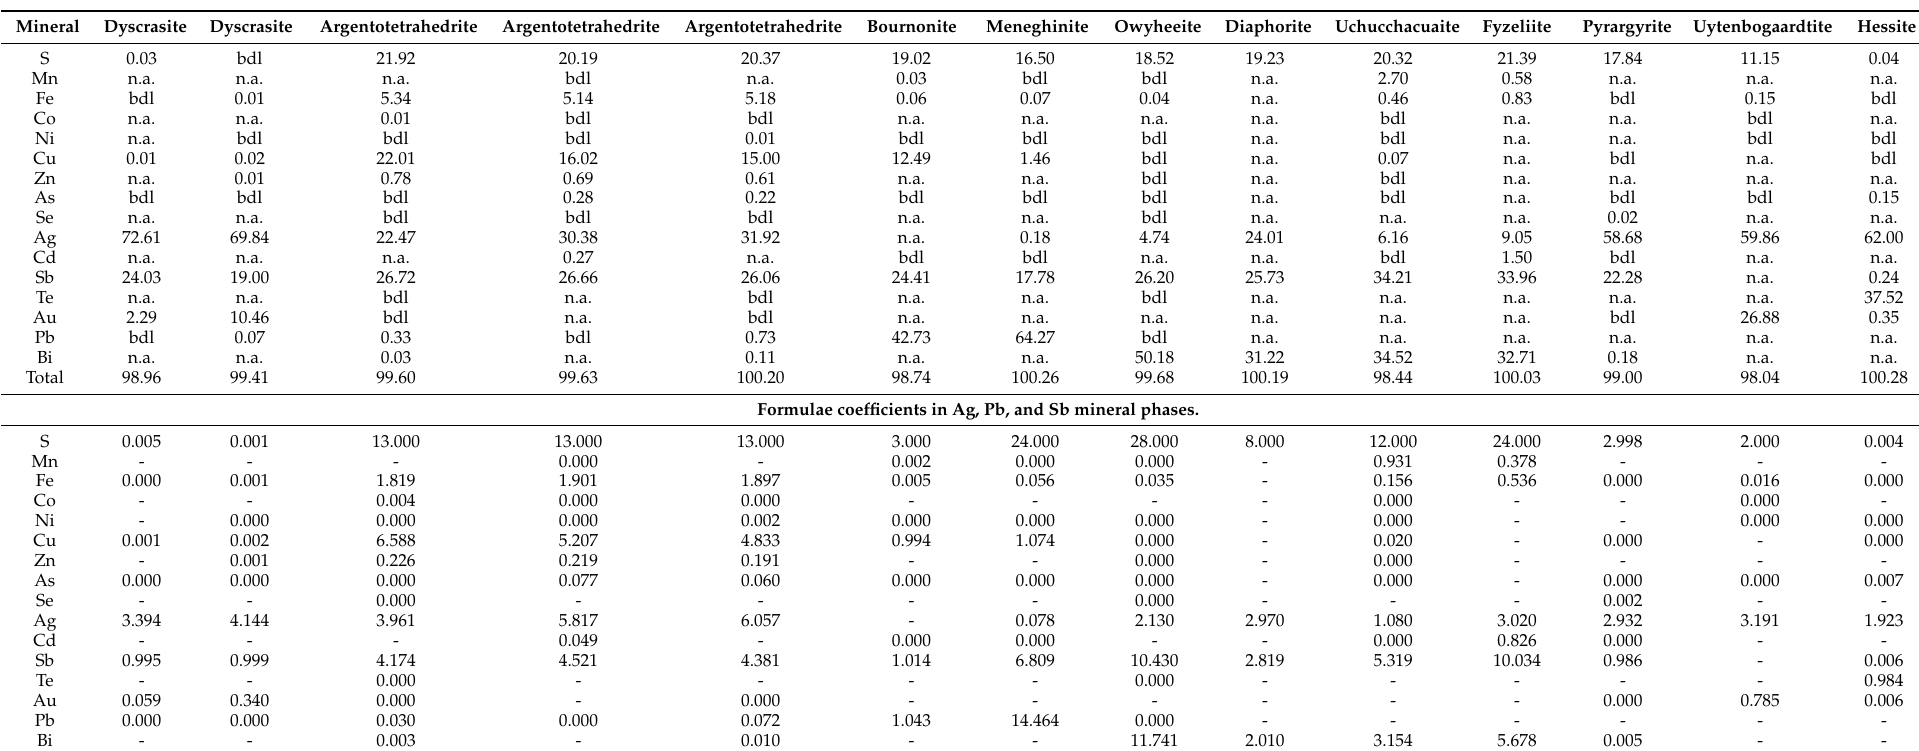
Table 7. Electron microprobe data in wt.% for selected Ag, Pb, and Sb mineral phases from the Oleninskoe